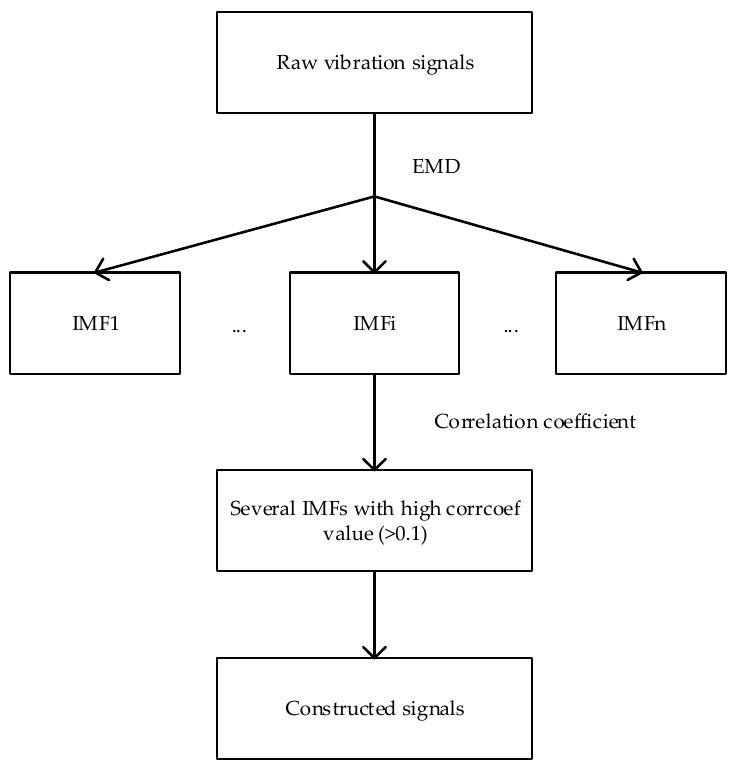
Figure 12. The pre ‐ process for de ‐ noising by EMD.